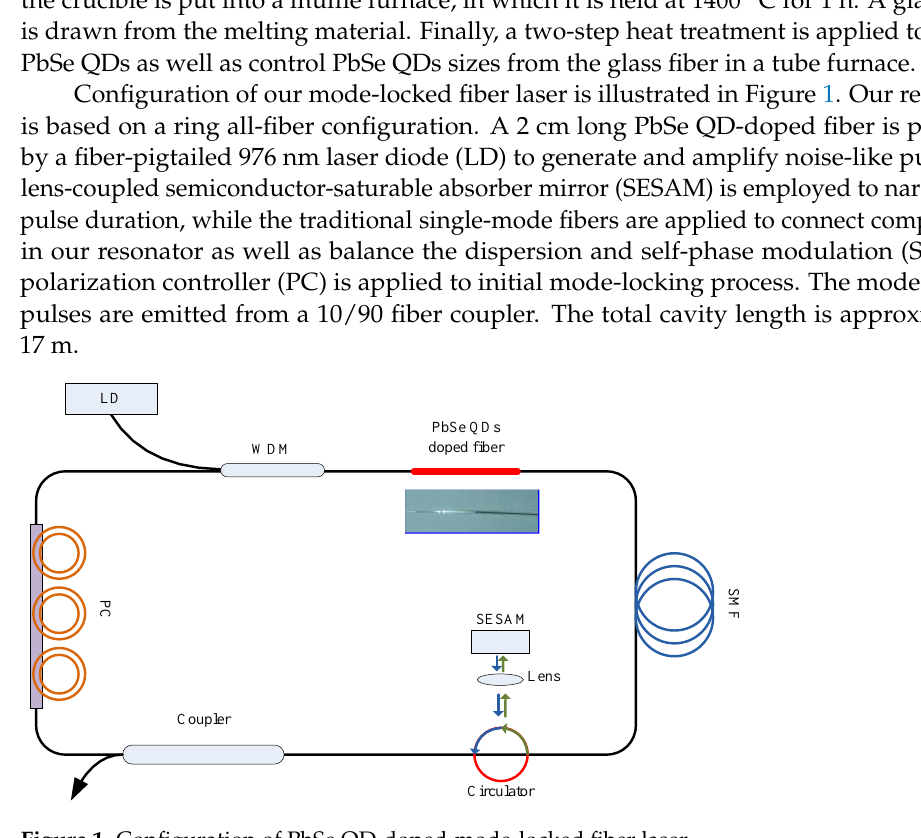
Figure 1. Configuration of PbSe QD-doped-mode-locked fiber laser.